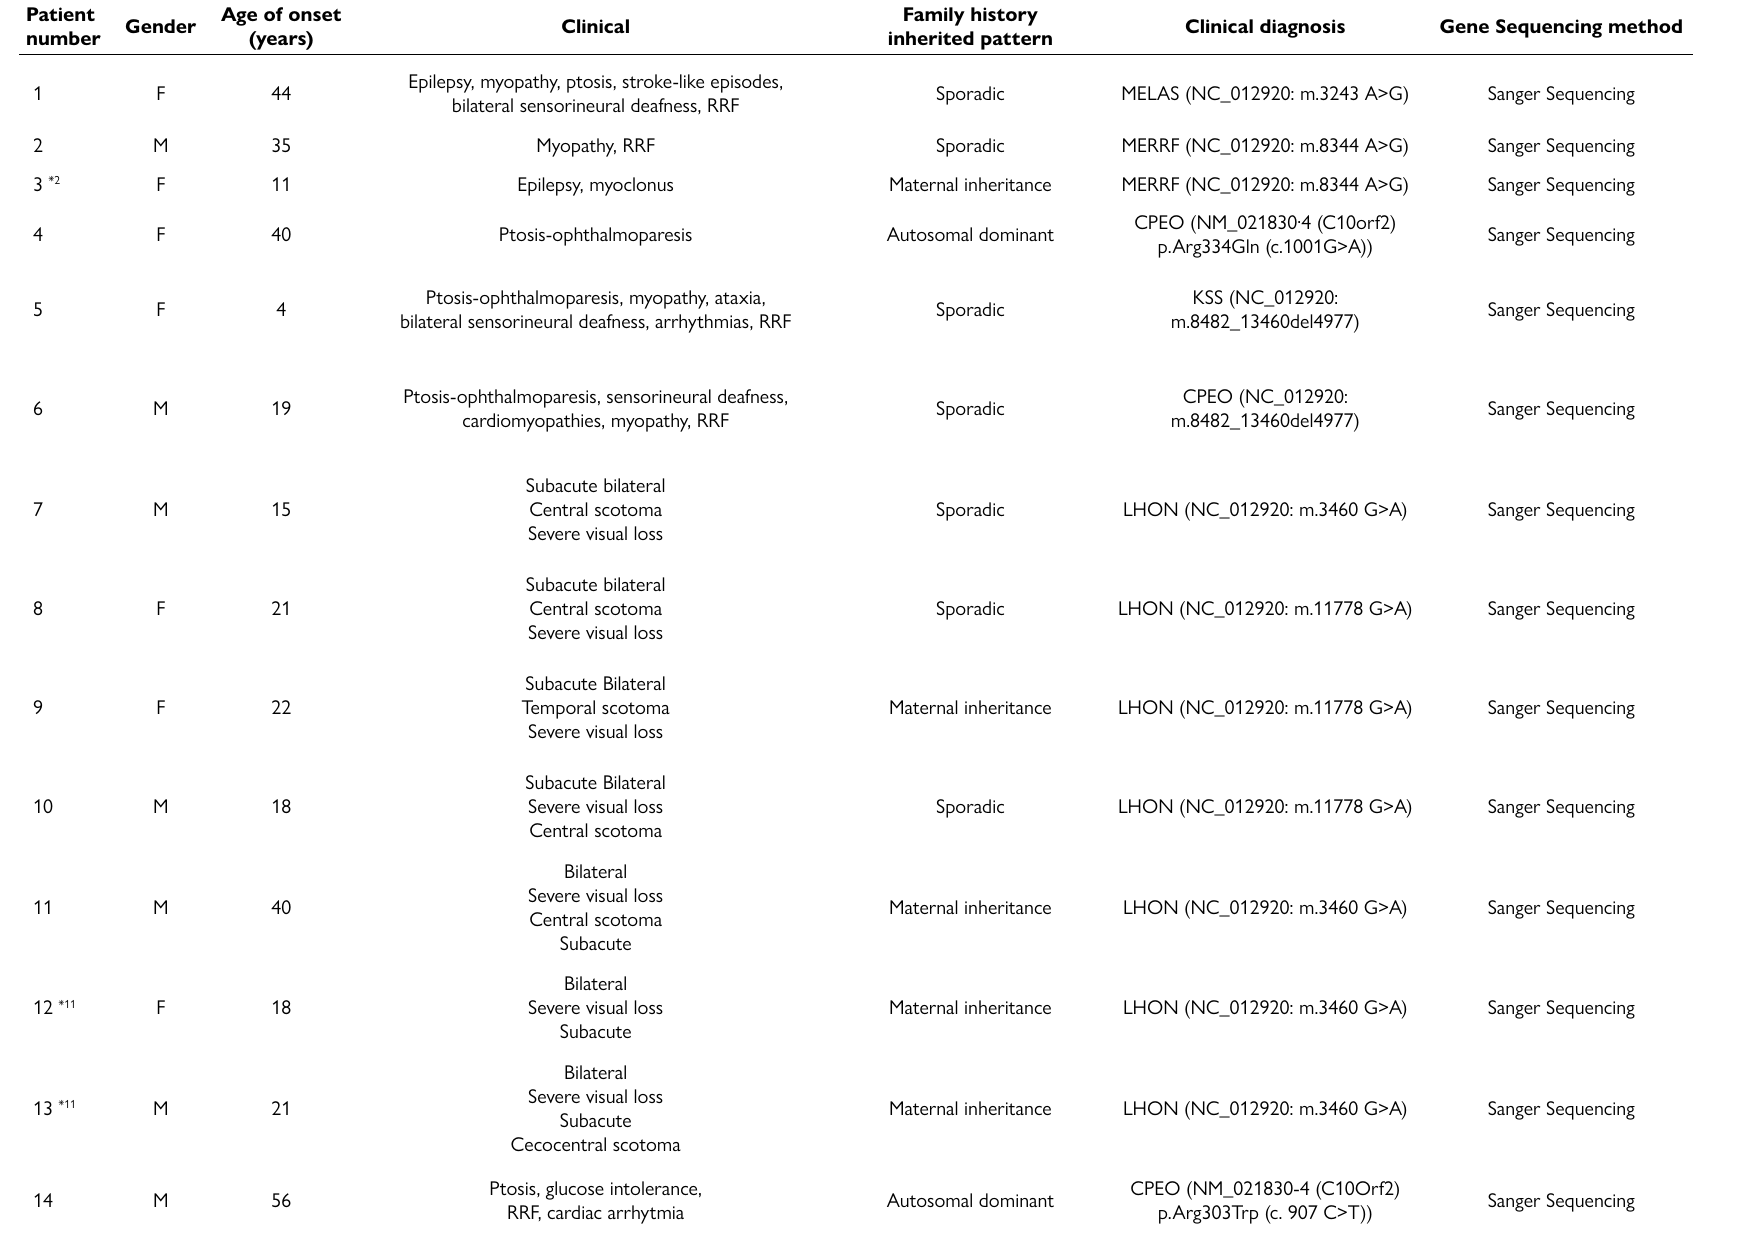
Table 1. Detail of the patients in whom a molecular defect was identified and their phenotypic